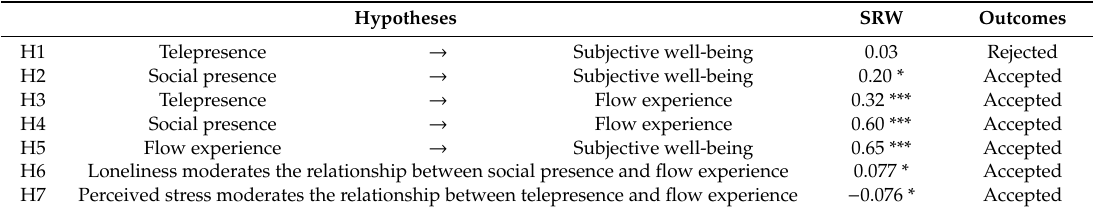
Table 7. Summary of hypotheses testing results.